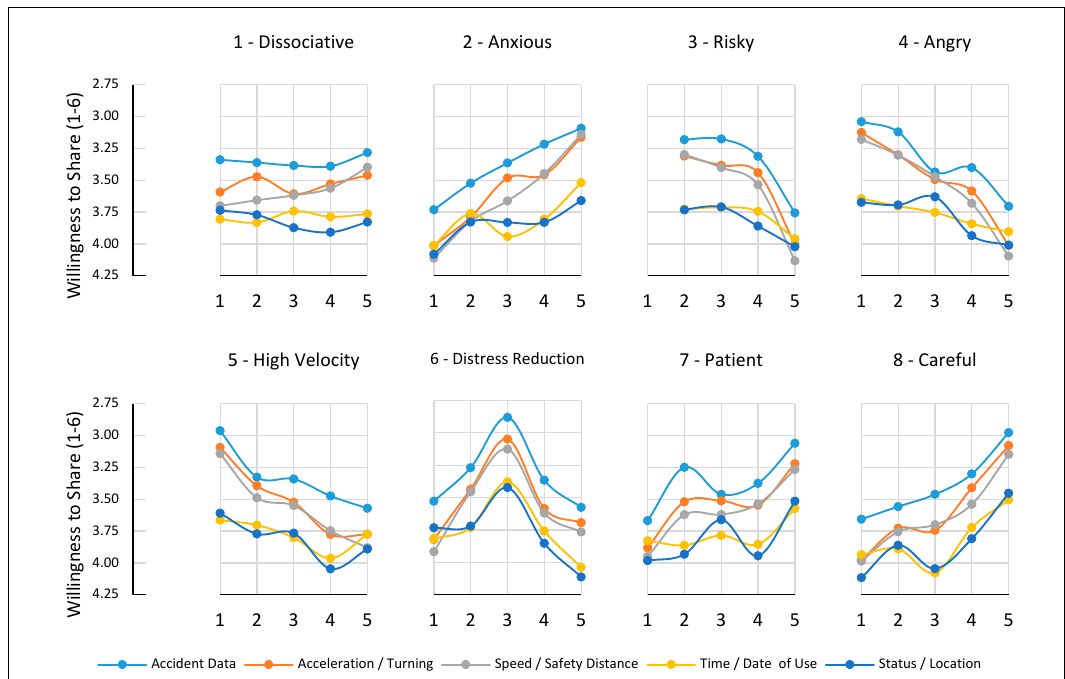
Figure 6. Impact of self-assessment quintile (1–5) on willingness to share information by type of information.